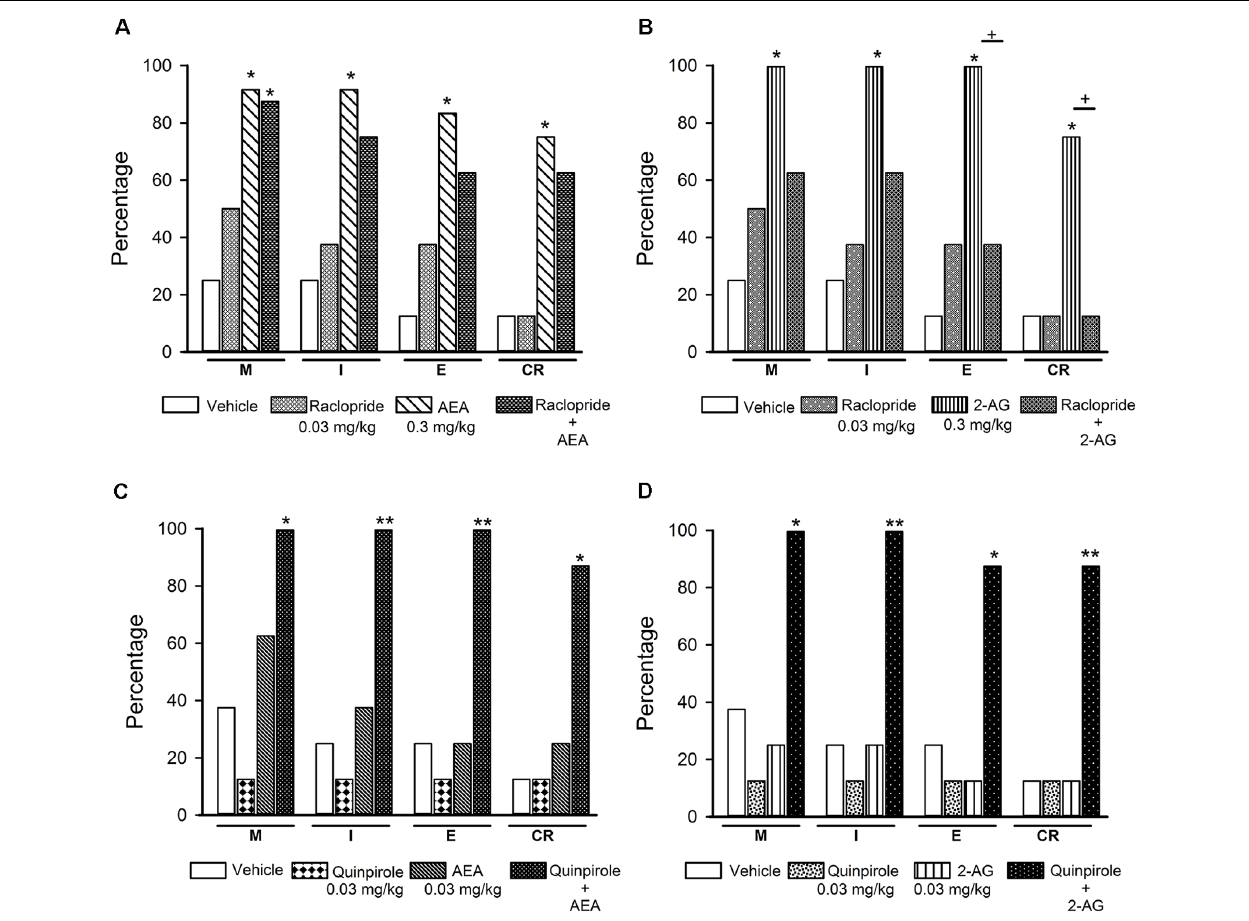
FIGURE 9 | Effects of the combined treatment of eCBs and D2-like receptor ligands on sexual behavior of sexually exhausted male rats. The upper graphs show the percentages of sexually satiated rats that are able to mount (M), intromit (I), ejaculate (E) and resume copulation after ejaculation (CR) following vehicle (1 ml/kg), the D2-like receptor antagonist Raclopride (0.03 mg/kg), AEA (0.3 mg/kg) or 2-AG (0.3 mg/kg) and the combined treatment of Raclopride with AEA (panel A ) or 2-AG (panel B ). The lower graphs depict the effects of vehicle (1 ml/kg), the D2-like receptor agonist Quinpirole (0.03 mg/kg) and their combined treatment with AEA (0.03 mg/kg; panel C ) or 2-AG (0.03 mg/kg; panel D ) on the percentages of satiated rats showing M, I, E and CR. Fisher F test, ∗ P < 0.05, ∗∗ P < 0.01, + P < 0.05; n = 8 for each group. Asterisks over bars indicate statistical significance vs. the control group; crosses show significance for other indicated